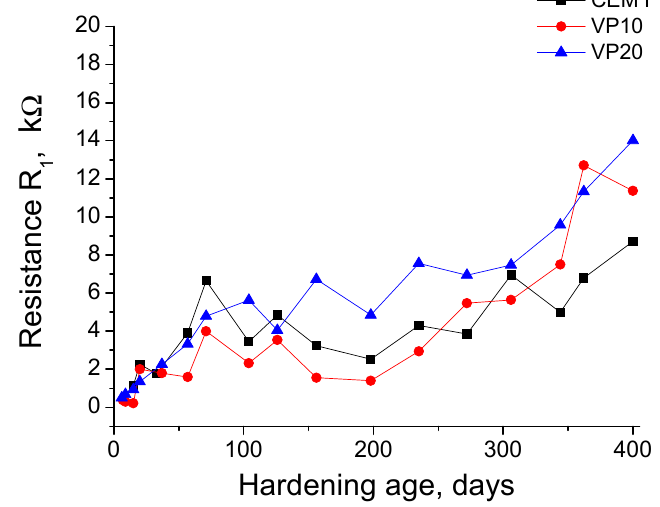
Figure 9. Impedance spectroscopy R 1 resistance for the mortars studied.